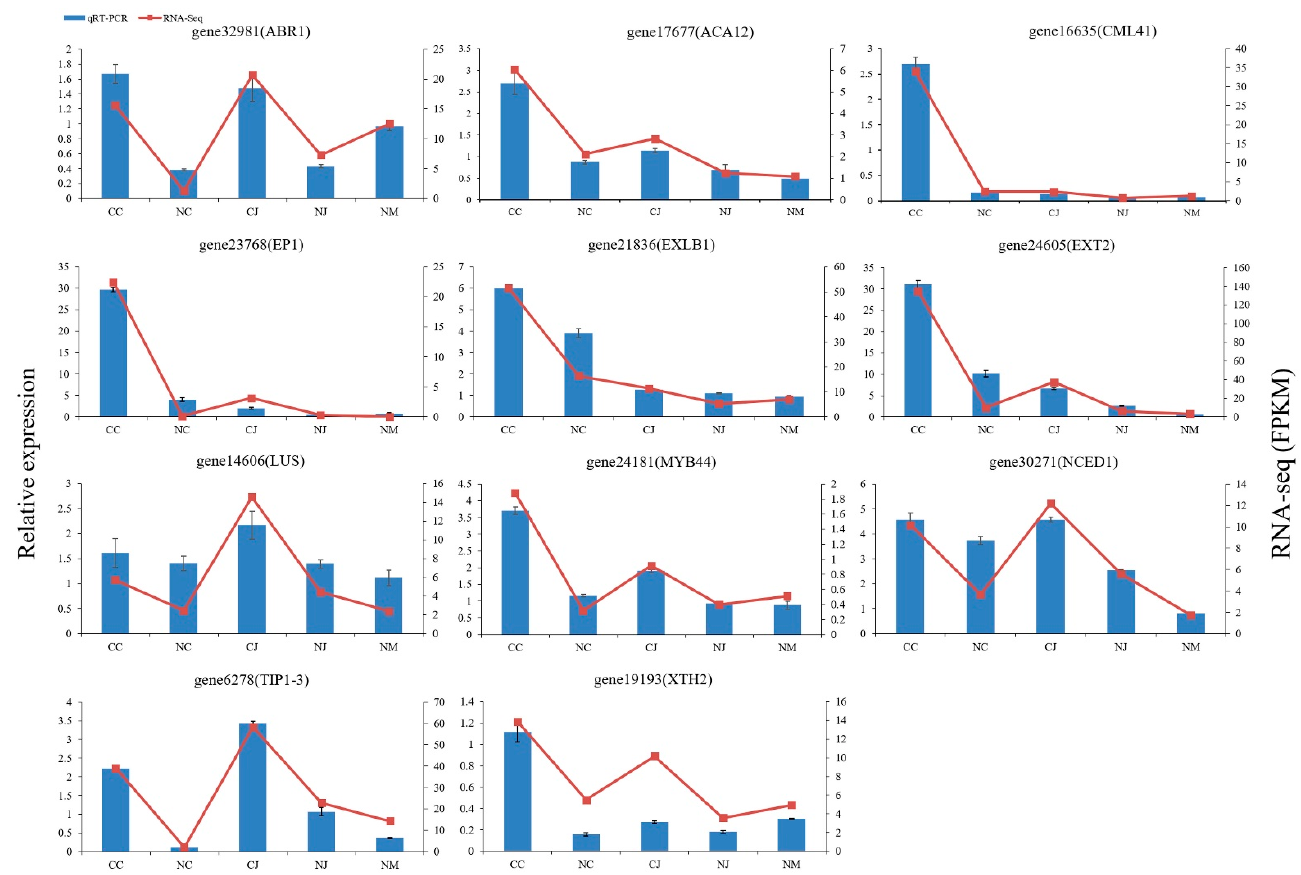
Figure 8. Comparison of RNA-seq results and qRT-PCR analysis of gene expression levels. Error bars represent standard 397 errors from three biological replicates. 398